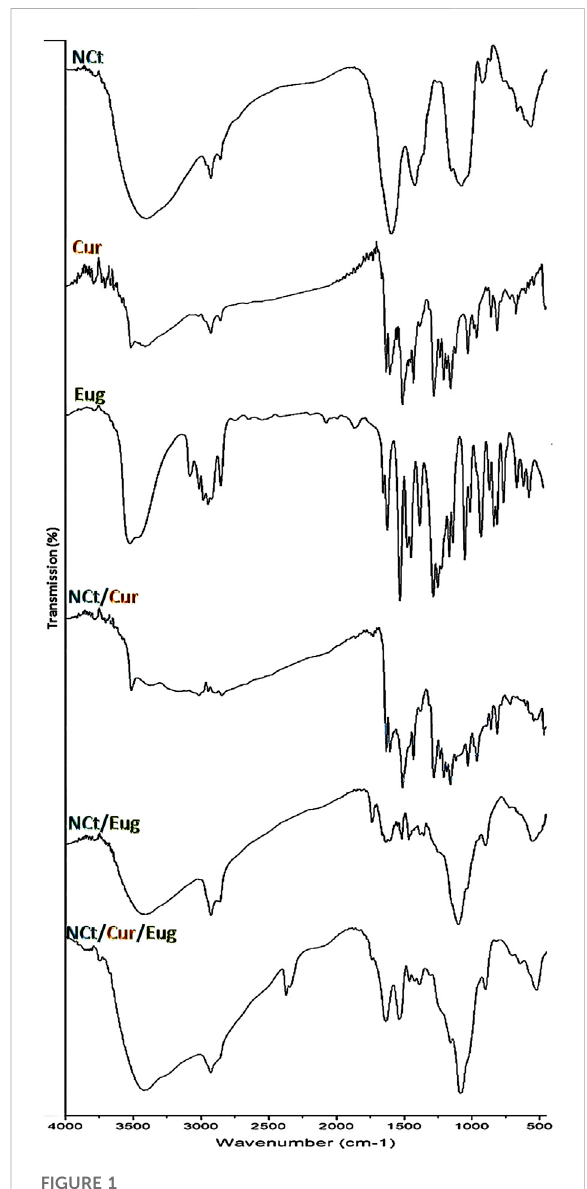
FTIR spectra of used agents/composites, including chitosan nanoparticles (NCt), curcumin (Cur), and eugenol